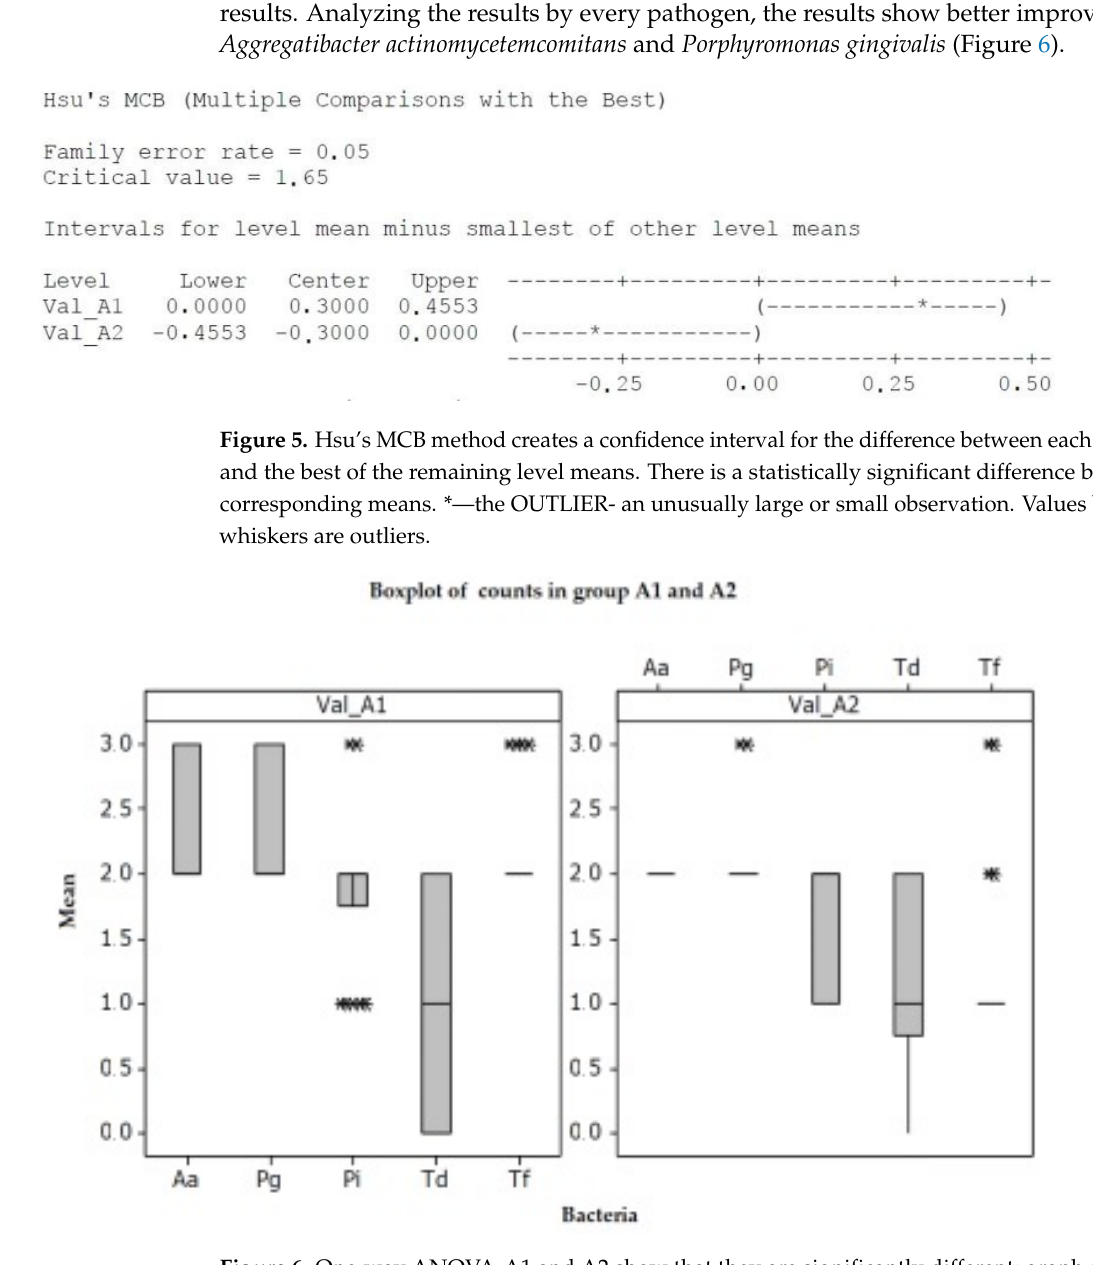
Figure 4. Mean bacterial count by groups, before treatment.